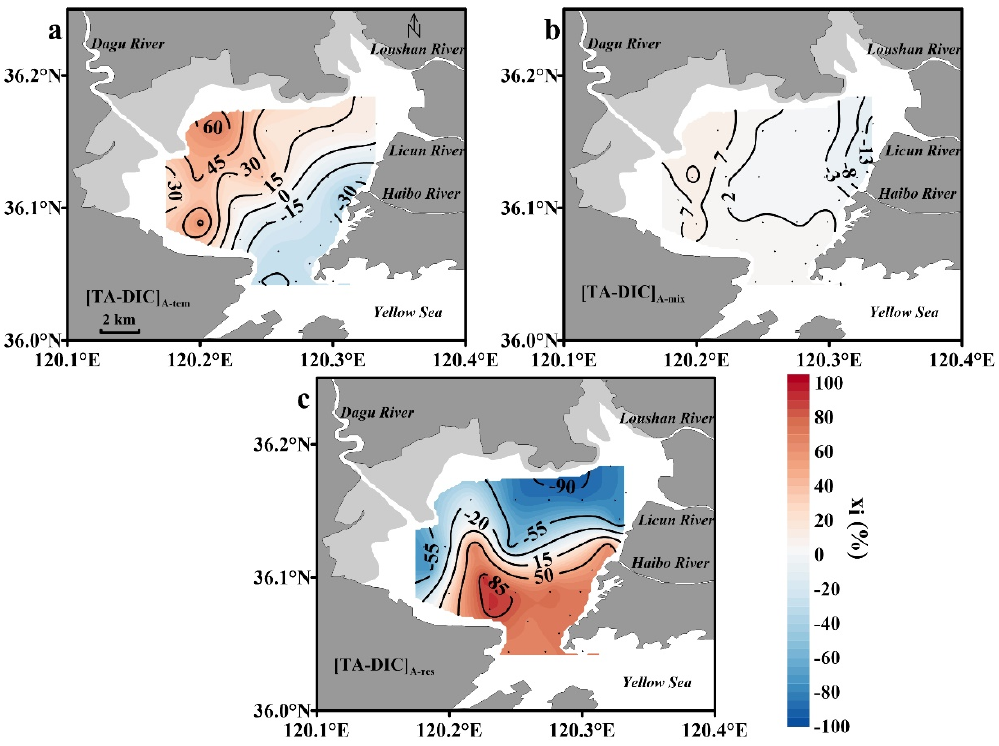
Figure 6. Relative contribution percentages of temperature ( a ), mixing processes ( b ) and other processes ( c ) to [TA-DIC] A in JZB during summer (28 June 2017).